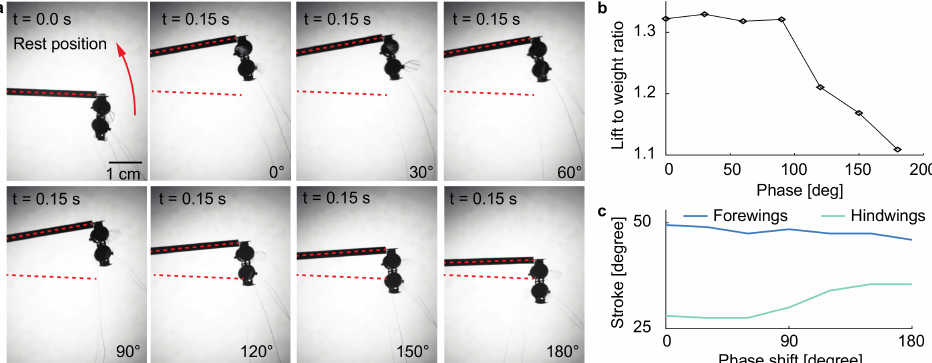
Figure 6. Liftoff experiments for quantifying the influence of phase shift θ on lift force production. ( a ) Robot rest position and final positions. In these experiments, the robot is driven at 1550 V, 350 Hz for 0.15 s while varying the phase shift θ . ( b ) Measured robot lift-to-weight ratio as a function of phase shift θ . ( c ) Measured forewing and hindwing stroke amplitudes as functions of phase shift θ . The stroke amplitudes shown in ( c ) are the average values of the left and right